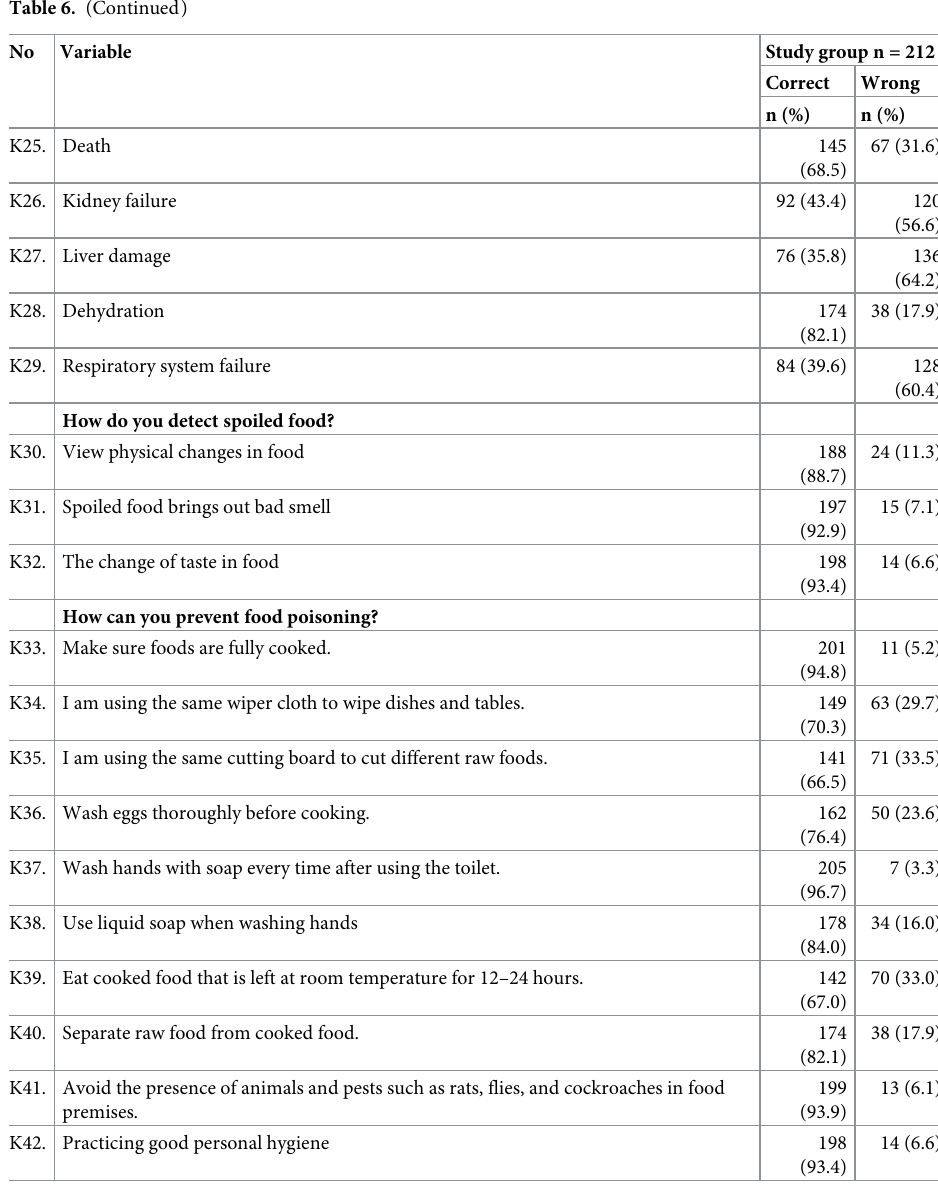
were among those that are male (83.2%), 35 years old and above (87.5%), non-Malaysian (88.4%), married (88.8%), non-first-degree holders (100.0%), not working (83.3%), had an average monthly income greater than or equal to RM3264 (84.2%), were not aware of food poi- soning outbreak (91.4%), and had no previous history of food poisoning illness (89.4%) (Table 7) . The bivariate analysis result displayed a significant association between citizen and poor knowledge of food poisoning (p = 0.018). The citizen that is non-Malaysian is 0.860 more likely to have poor knowledge compared to the citizen that is Malaysian with poor knowledge (Confidence Interval 95%: 0.756–0.978) (Table 7)